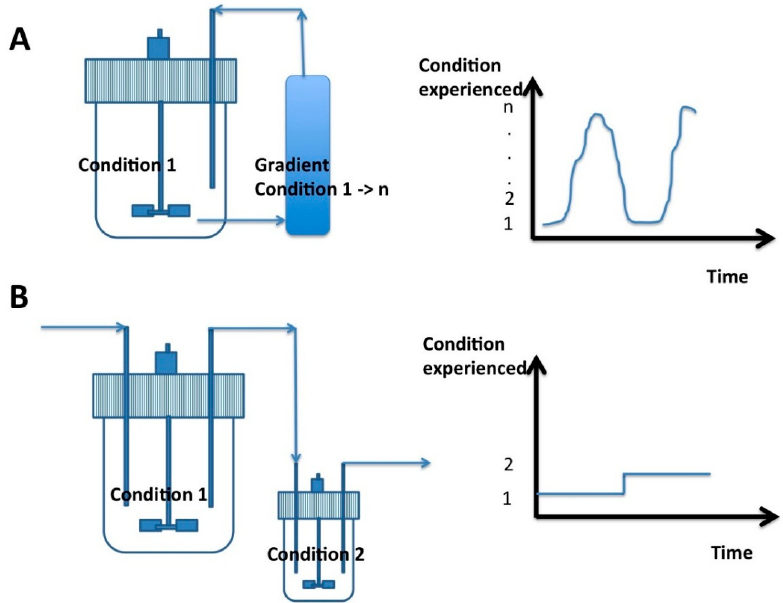
Figure 1. Fermentation devices that can be used for improving the viability of probiotics: ( A ) Batch cultivation devices based on the recirculation of microbial cells between a stirred bioreactor and a plug-flow recycle loop. By his way, gradient of environmental conditions can be generated at the level of the recycle loop allowing to expose the cells to progressive and recurrent stresses [8]; ( B ) Continuous cultivation devices based on two stirred bioreactors in series. In this case, only two distinct cultivation conditions can be generated. However, this device had the advantage of maintaining the microbial population at a given stage by chemostat control [7]. Typical single cell traces ( i.e. , the history of environmental conditions met by cells) are represented for each bioreactor. As shown, the plug-flow recycle loop allows for the generation of much more variable environmental states from 1 to n (depending on the operating conditions).